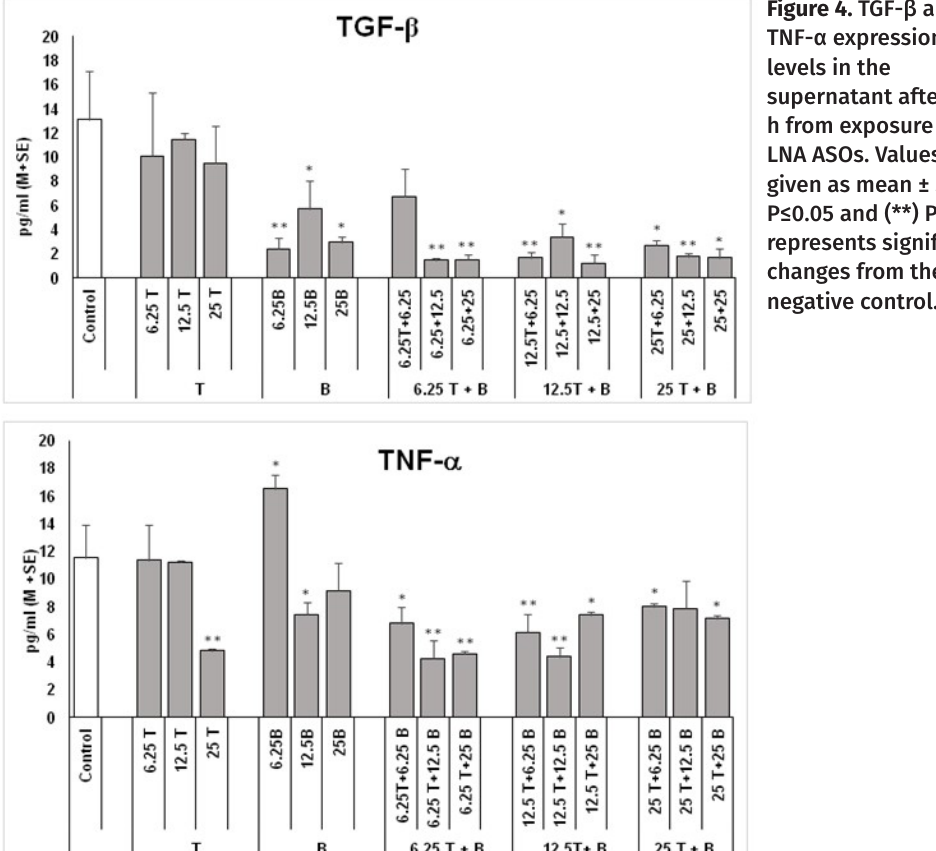
Figure 4. TGF-β and TNF-α expression levels in the supernatant after 48 h from exposure to LNA ASOs. Values are given as mean ± S.E. (*) P≤0.05 and (**) P≤0.01 represents significant changes from the negative